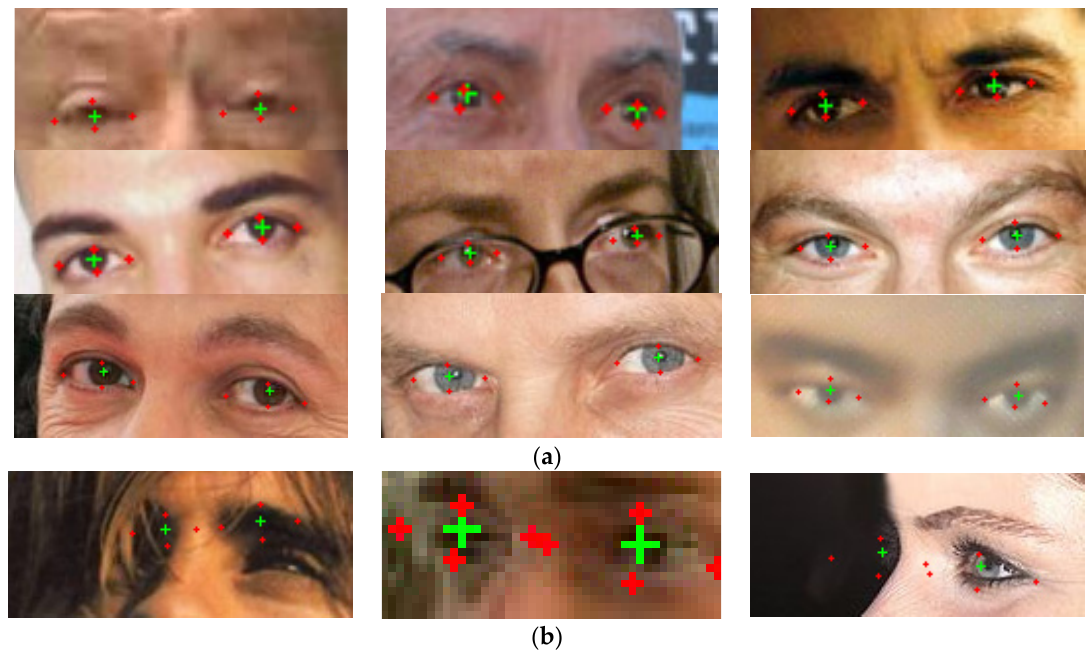
Figure 23. Results on the LFPW database. The eye centers are depicted with a green cross and the landmarks used to generate the shape of the eyelids are marked red crosses. ( a ) Results; and ( b ) failure cases.